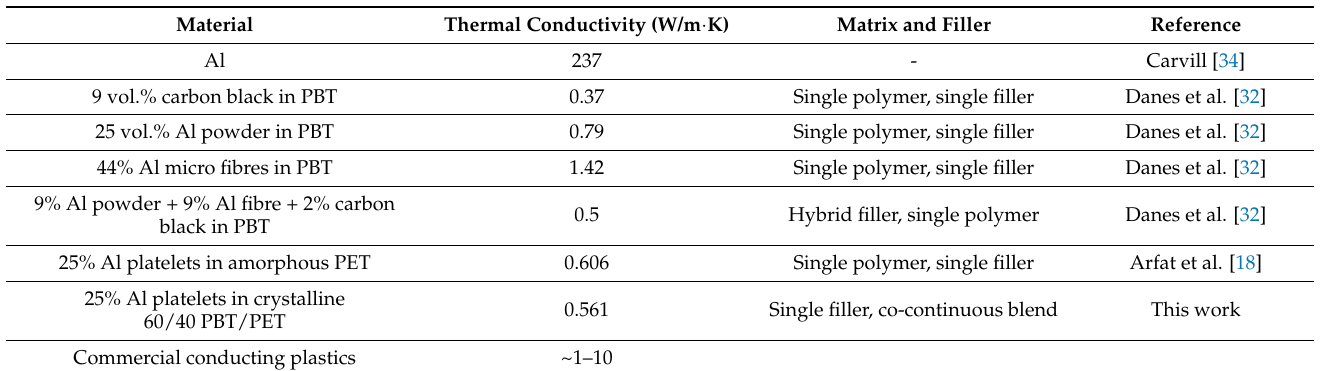
Table 4. Thermal conductivity of plastics filled with different types of